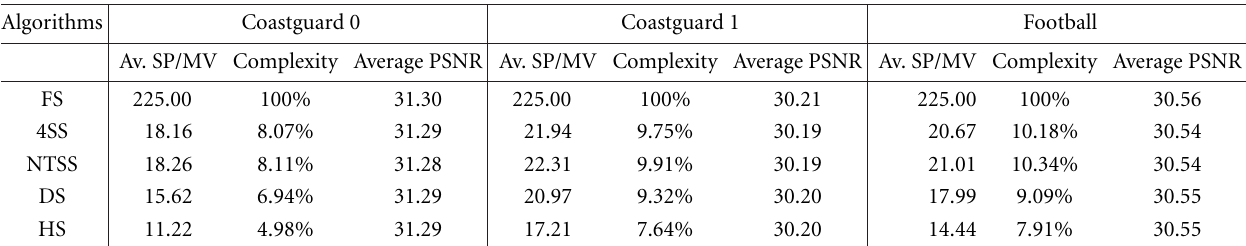
Table 2: Average search points (SP) per motion vector (MV) estimation and PSNR for the first 100 frames.